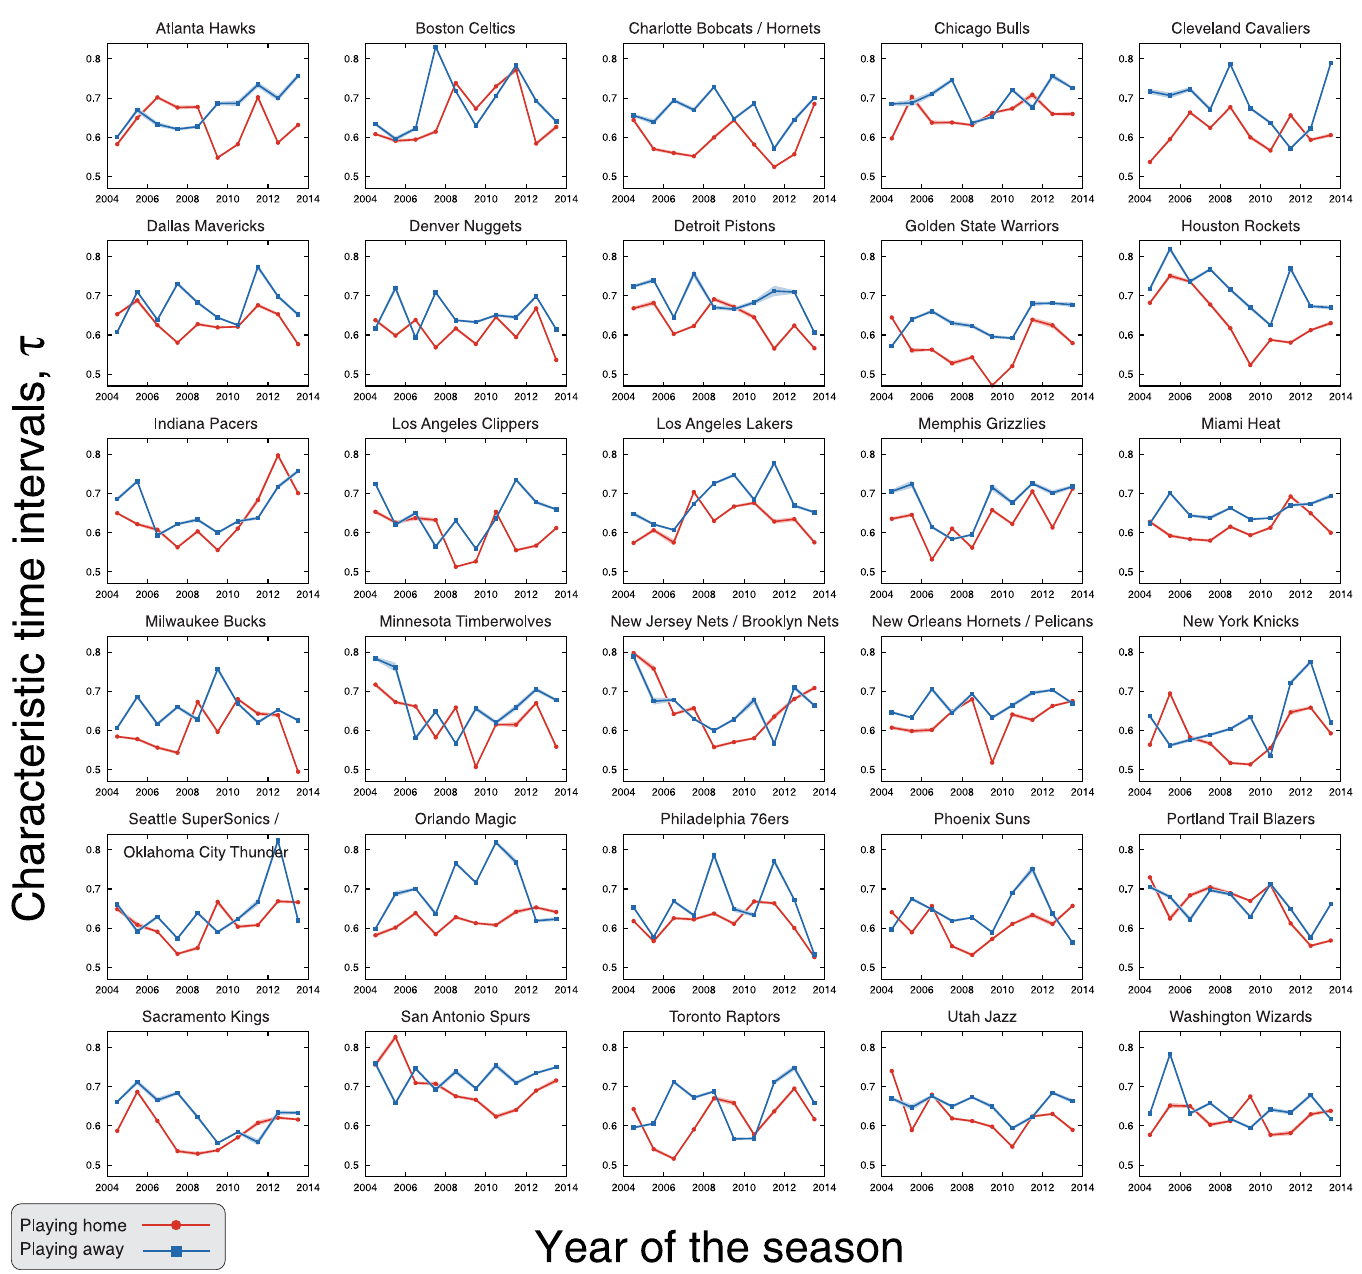
Fig 6. Evolution of the characteristic time intervals when playing home and away for each NBA team. The panels show the characteristic time intervals between scores when playing home ( τ home , red circles) and away ( τ away , blue squares) for every team and season from 2004 – 05 to 2013 – 14, period in which the teams were the same. Here we have aggregated data from all quarters and estimated the characteristic times via maximum likelihood method. The shaded areas are 95% bootstrap confidence intervals. Notice that the characteristic times are systematically larger when the team plays away; still, we note some inversions and that the values vary among teams and